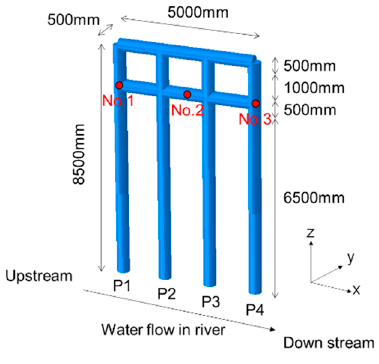
Figure 6. FEM models for the pier.